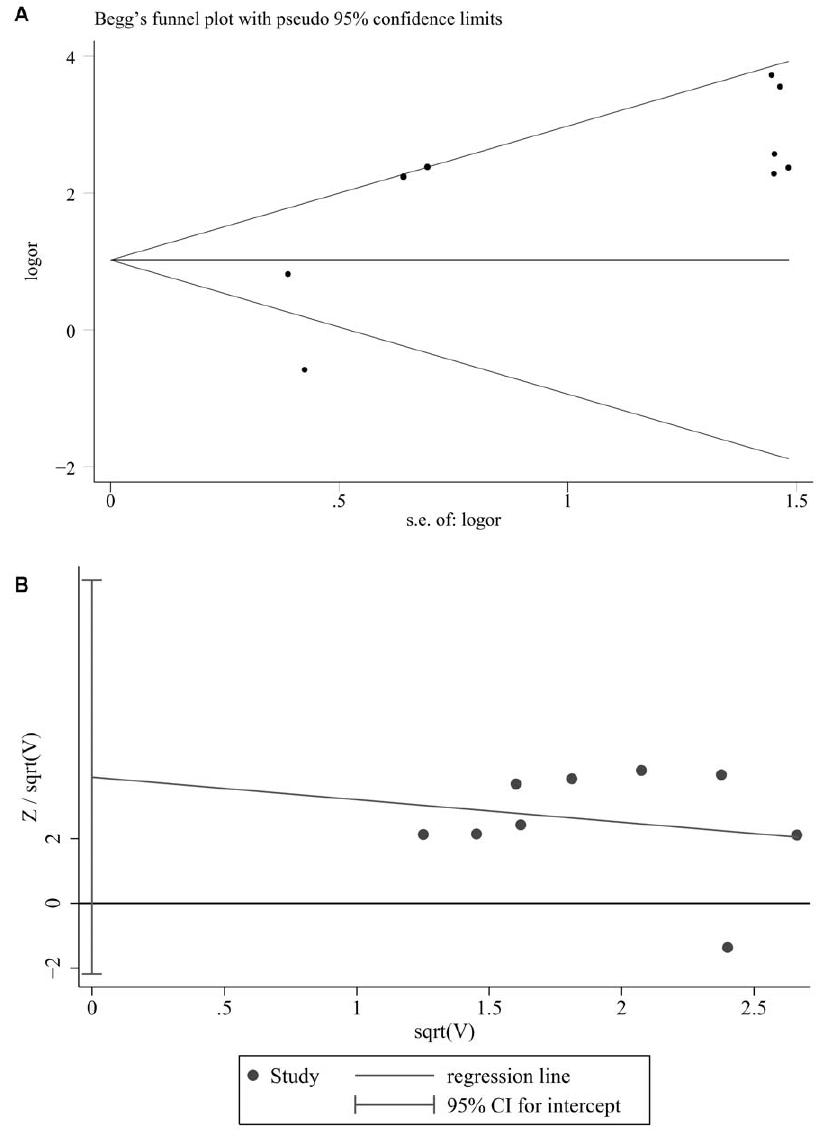
Figure 3. Estimating publication bias by Begg’s test (A) and Harbord’sweightedlinearregression test (B). Begg’s test (A) was adopted for measuring publication bias and showed a non-significant publication bias ( P =0.917). Harbord’s weighted linear regression (B) also indicated a non- significant publication bias ( P =0.173).